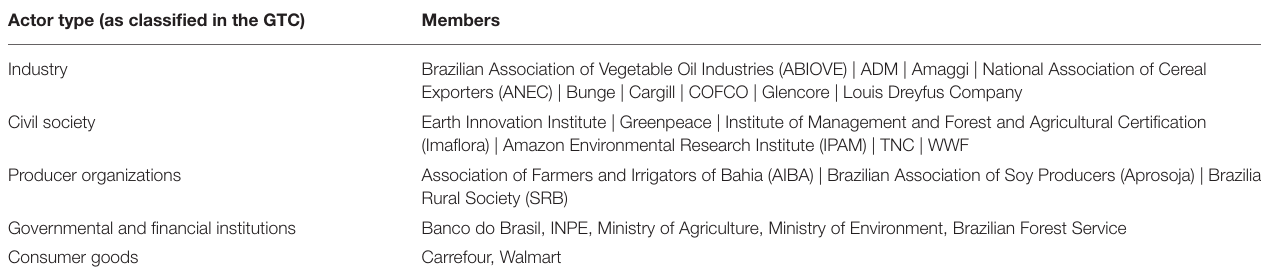
TABLE 1 | Members of the Cerrado Working Group (GTC) a . Actor type (as classified in the